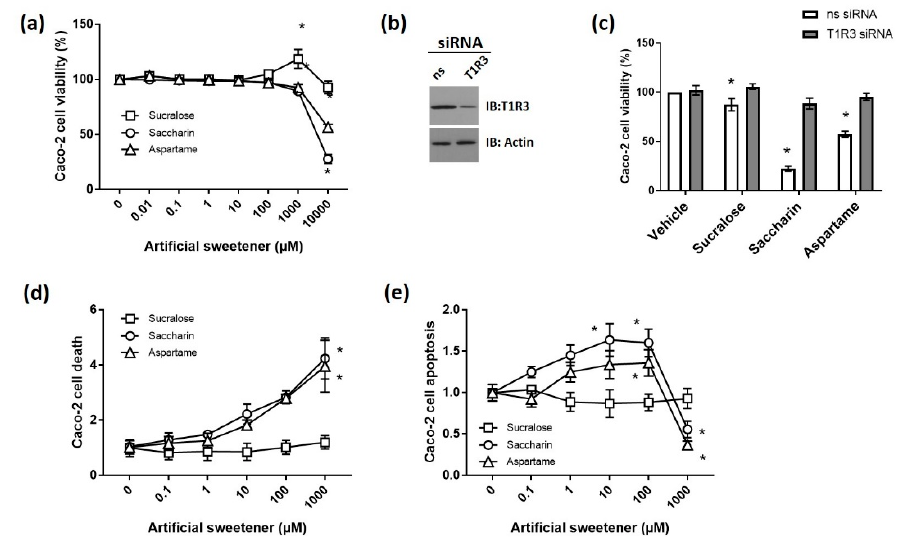
Figure 1. High physiological concentrations of artificial sweeteners decreased the viability